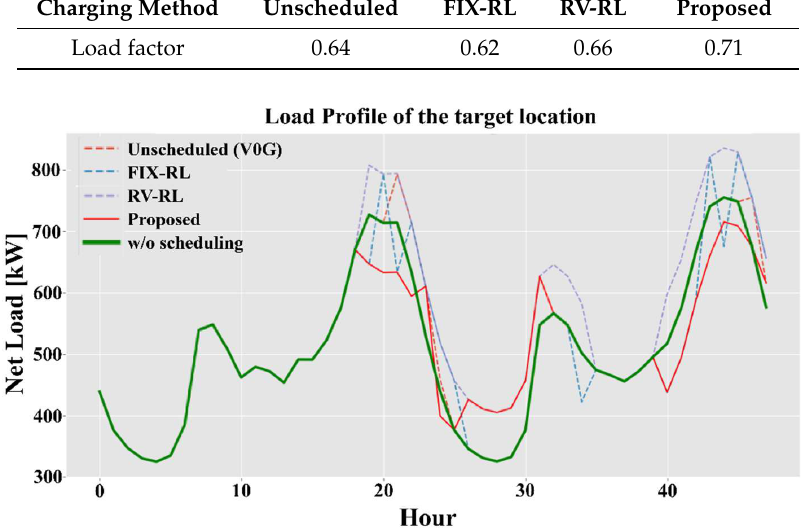
Figure 11. Load shifting effect when charging and discharging of EVs are scheduled. Table 4. Calculated load factor of unscheduled method and proposed method.